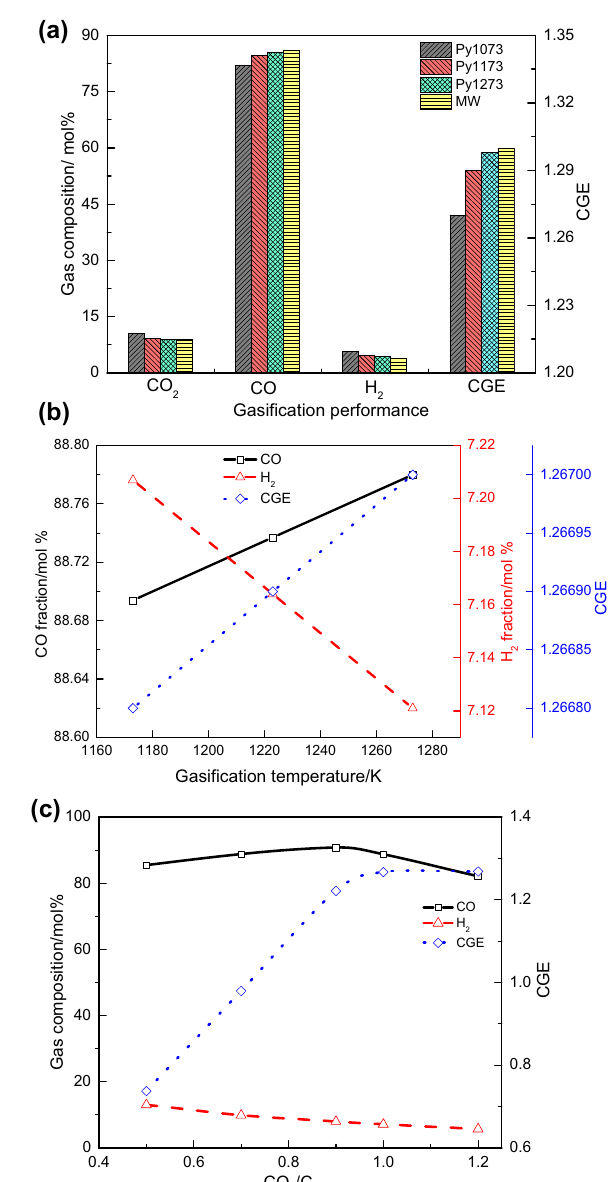
Fig. 7 Gasification performance of the char-CO 2 system: Effects of a the pyrolysis temperature, b the gasification temperature, and c the